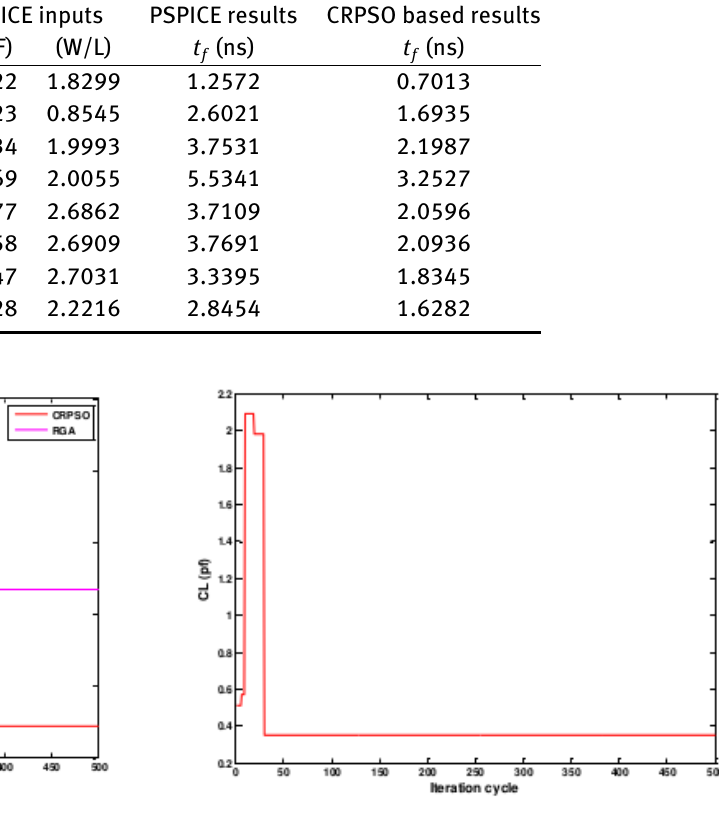
Table 10: PSPICE based results versus CRPSO based results for the Case study-1. Design set no.